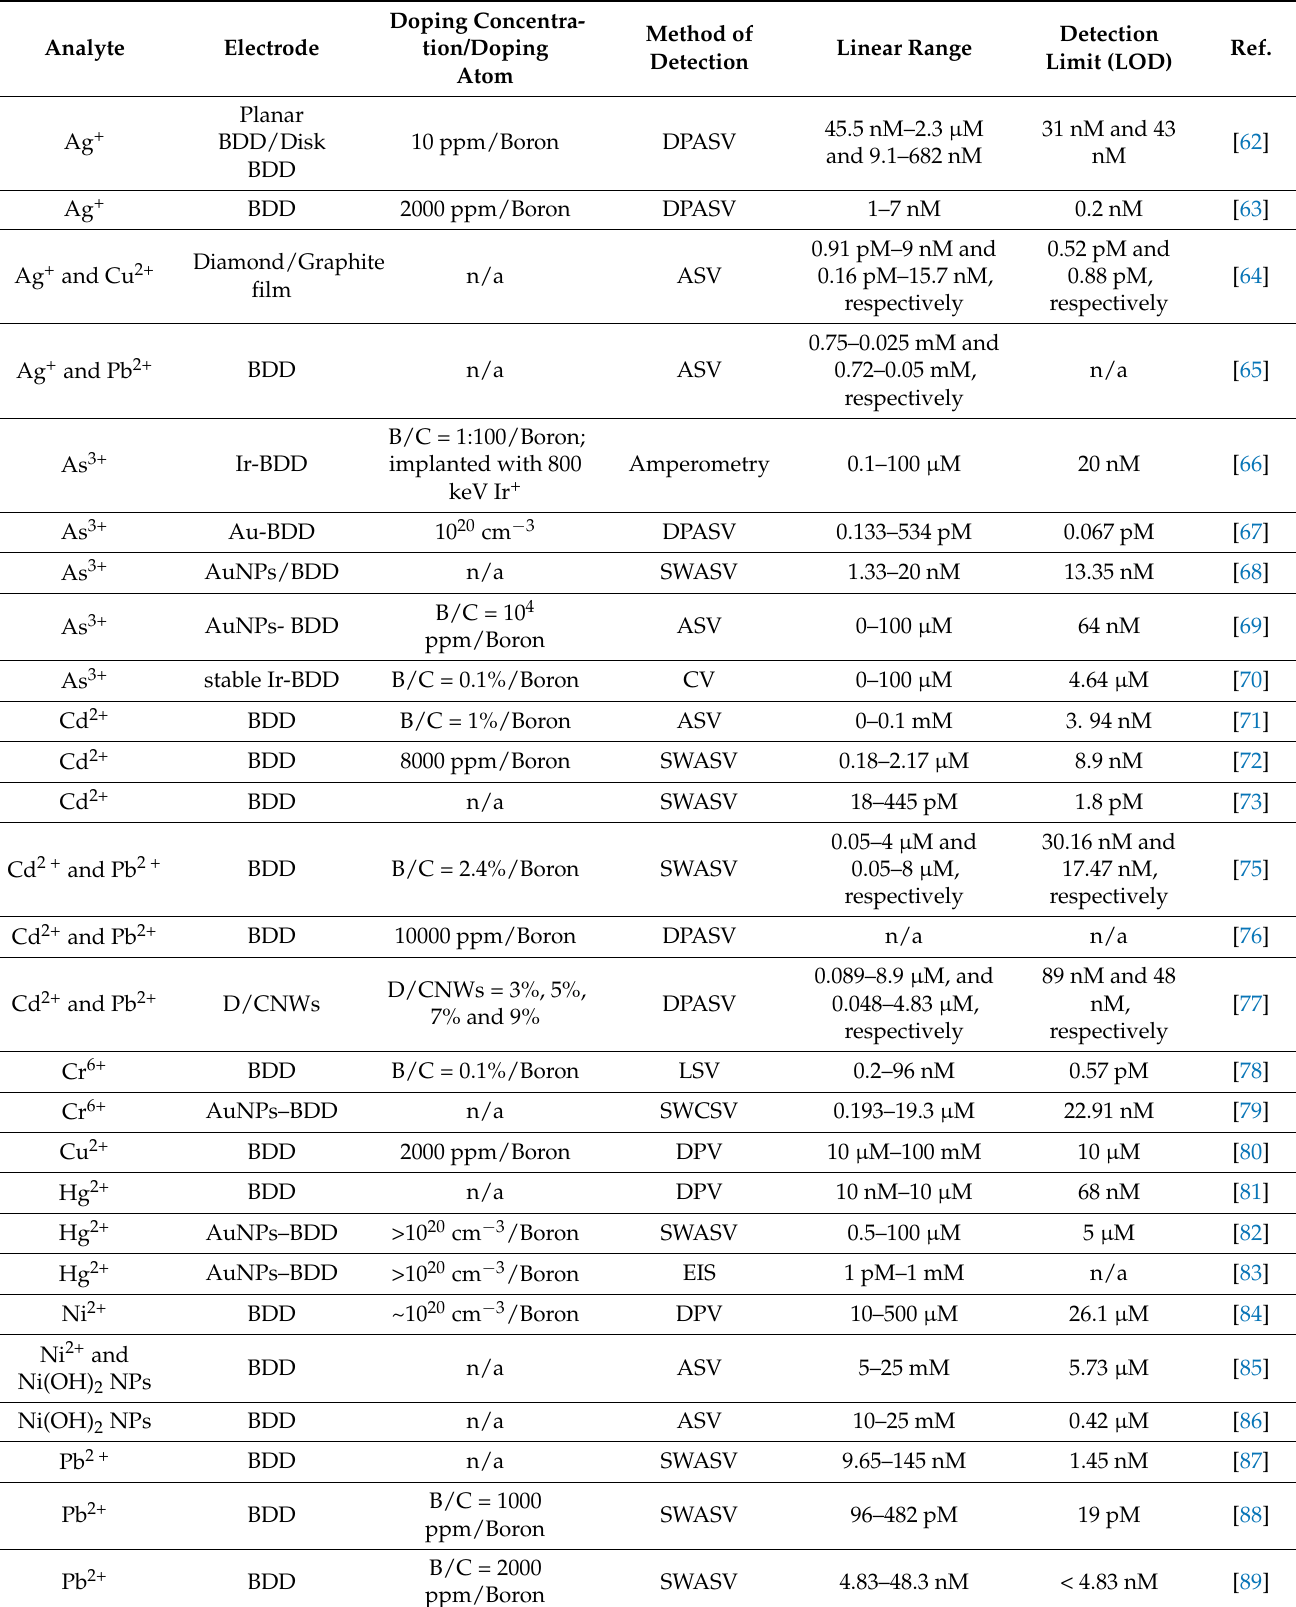
Table 1. Summary of diamond-based electrodes in the detection of metal